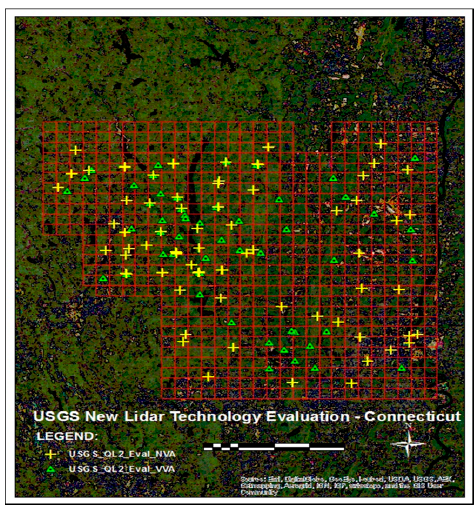
Figure 3. Location of checkpoints used for Vertical Accuracy Assessments. Plus signs are NVA checkpoints. Triangles are VVA checkpoints